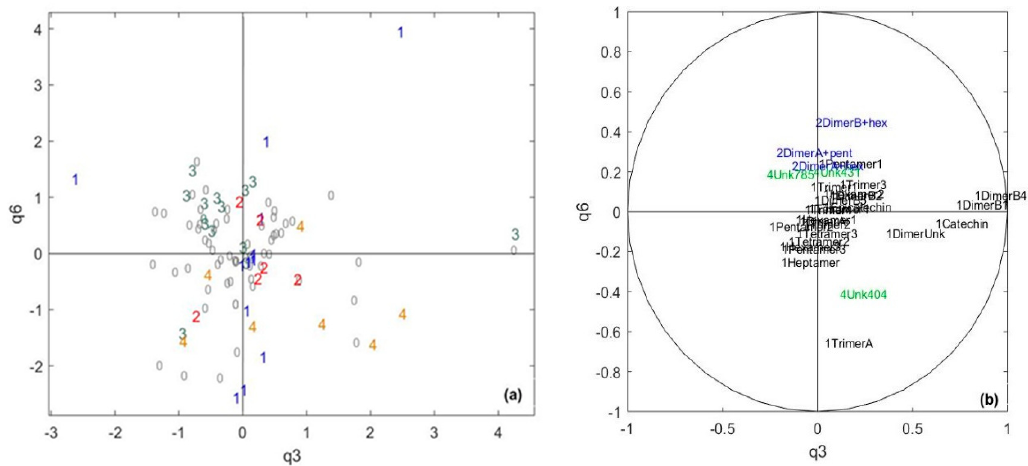
Figure 3. The CCSWA on the chocolate and sensory data, the specific space of the polyphenolic chocolate data: ( a ) score plot and ( b ) correlation circle. 1 = core pole 1, 2 = core pole 2, 3 = core pole 3, 4 = core pole 4, and 0 = samples not belonging to any core pole. Black = flavan-3-ols, blue = glycosylated flavan-3-ols and green = unknown compounds.